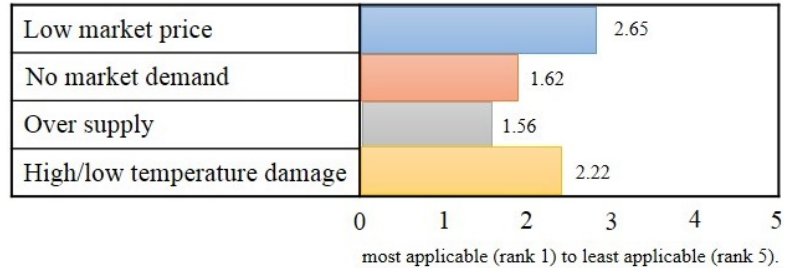
Figure 4. Food loss generation categories and mean rankings produced from participant responses.